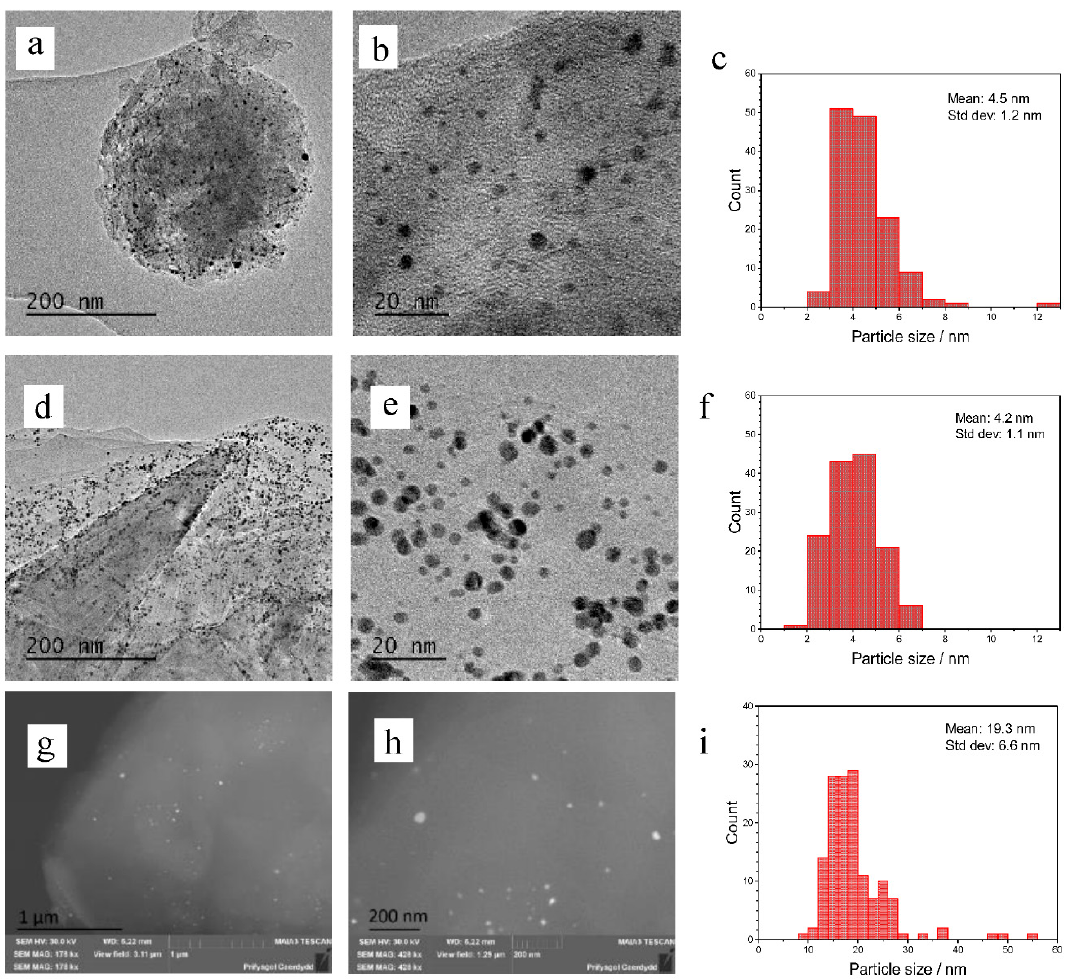
Figure 1. ( a , b ) Bright field transmission electron microscopy (TEM) images of 1% Au/graphene via sol immobilisation show mean particle diameter of 4.5 nm, standard deviation of 1.2 nm shown in ( c ). Bright field TEM images ( d , e ) of 1% Au/graphite via sol immobilisation show mean particle diameter of 4.2 nm, standard deviation of 1.1 nm shown in ( f ). Back-scattered electrons (BSE) images ( g , h ) of 1% Au/graphite prepared by impregnation show mean particle size of 19.3 nm and a standard deviation of 6.6 nm shown in ( i ).